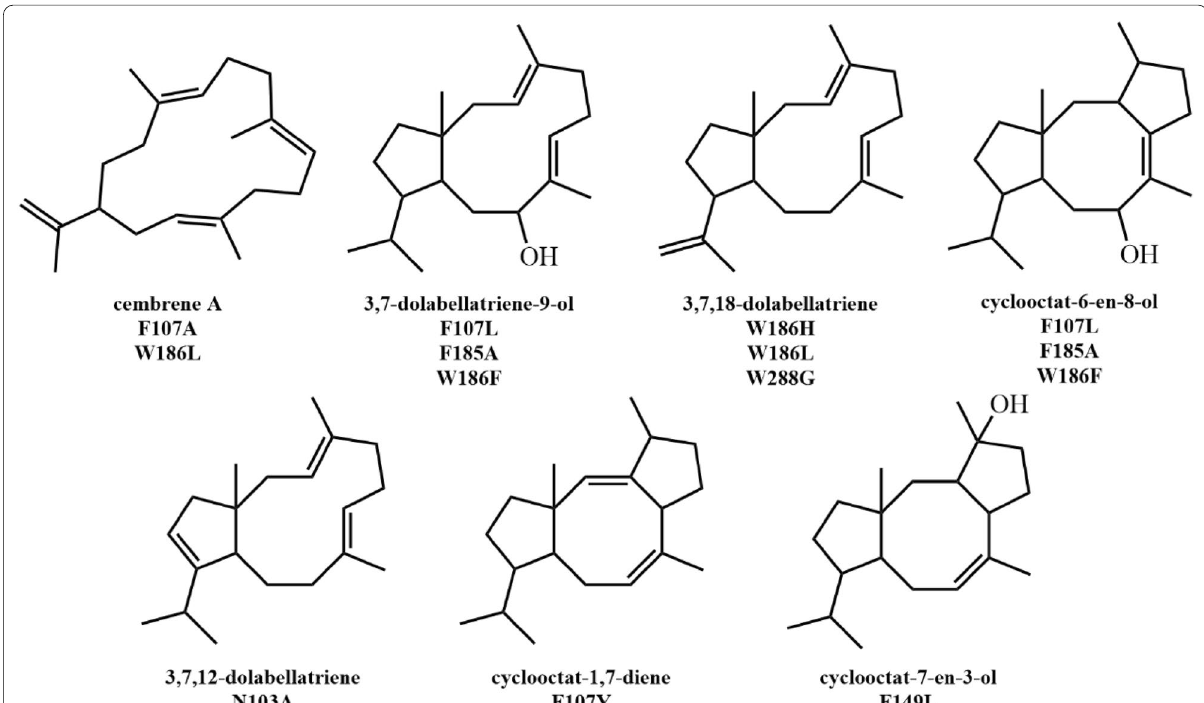
Fig. 16 Products of CotB2 mutants. Products of the corresponding mutants were summarized from refs. (Görner et al. 2013; Janke et al. 2014; Tomita et al.